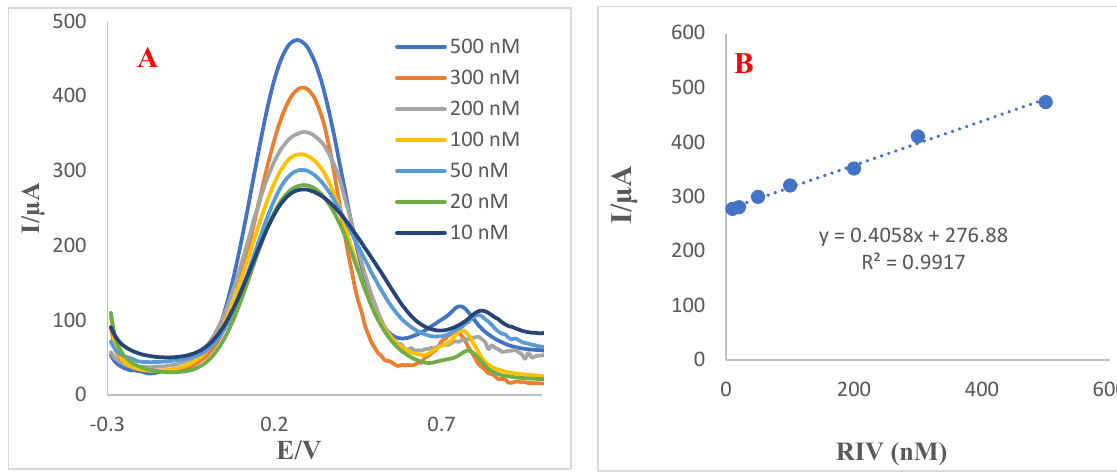
Figure 2. ( A ) SWVs of the engineered aptasensor ITO-PET/OH/AuNPs/aptamer in different concentrations of RIV (500, 300, 200, 100, 50, 20, and 10 nM); ( B ) calibration curve of the aptasensor. Scan rate is 100 mVs − 1 . Supporting electrolyte is [Fe(CN) 6 ] 3 − /4 − / KCl (0.01 M). (Incubation time is 20 min.) (E beging = − 1 V, E end = 1 V, amplitude time = 0.25 s, frequency 1 Hz.) (n = 3.)